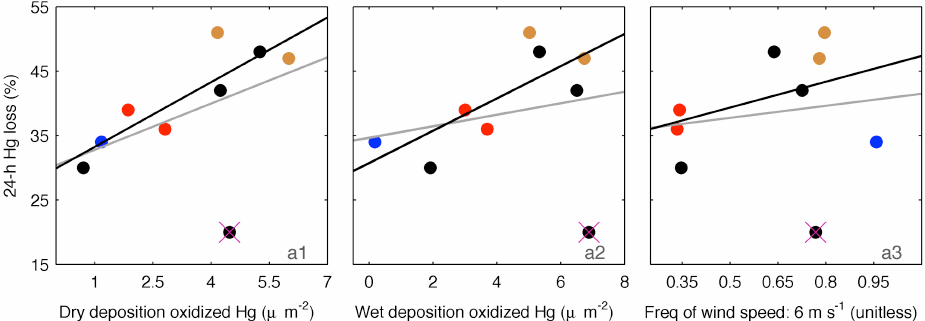
Fig. 3. Scatter plots of sufficiently strongly and significantly correlated model environmental variables with Set2’s 24-h fractional loss of mercury from surface snow. The colour coding follows that of Fig. 2. The black line was estimated by the bivariate linear regression for Set2.